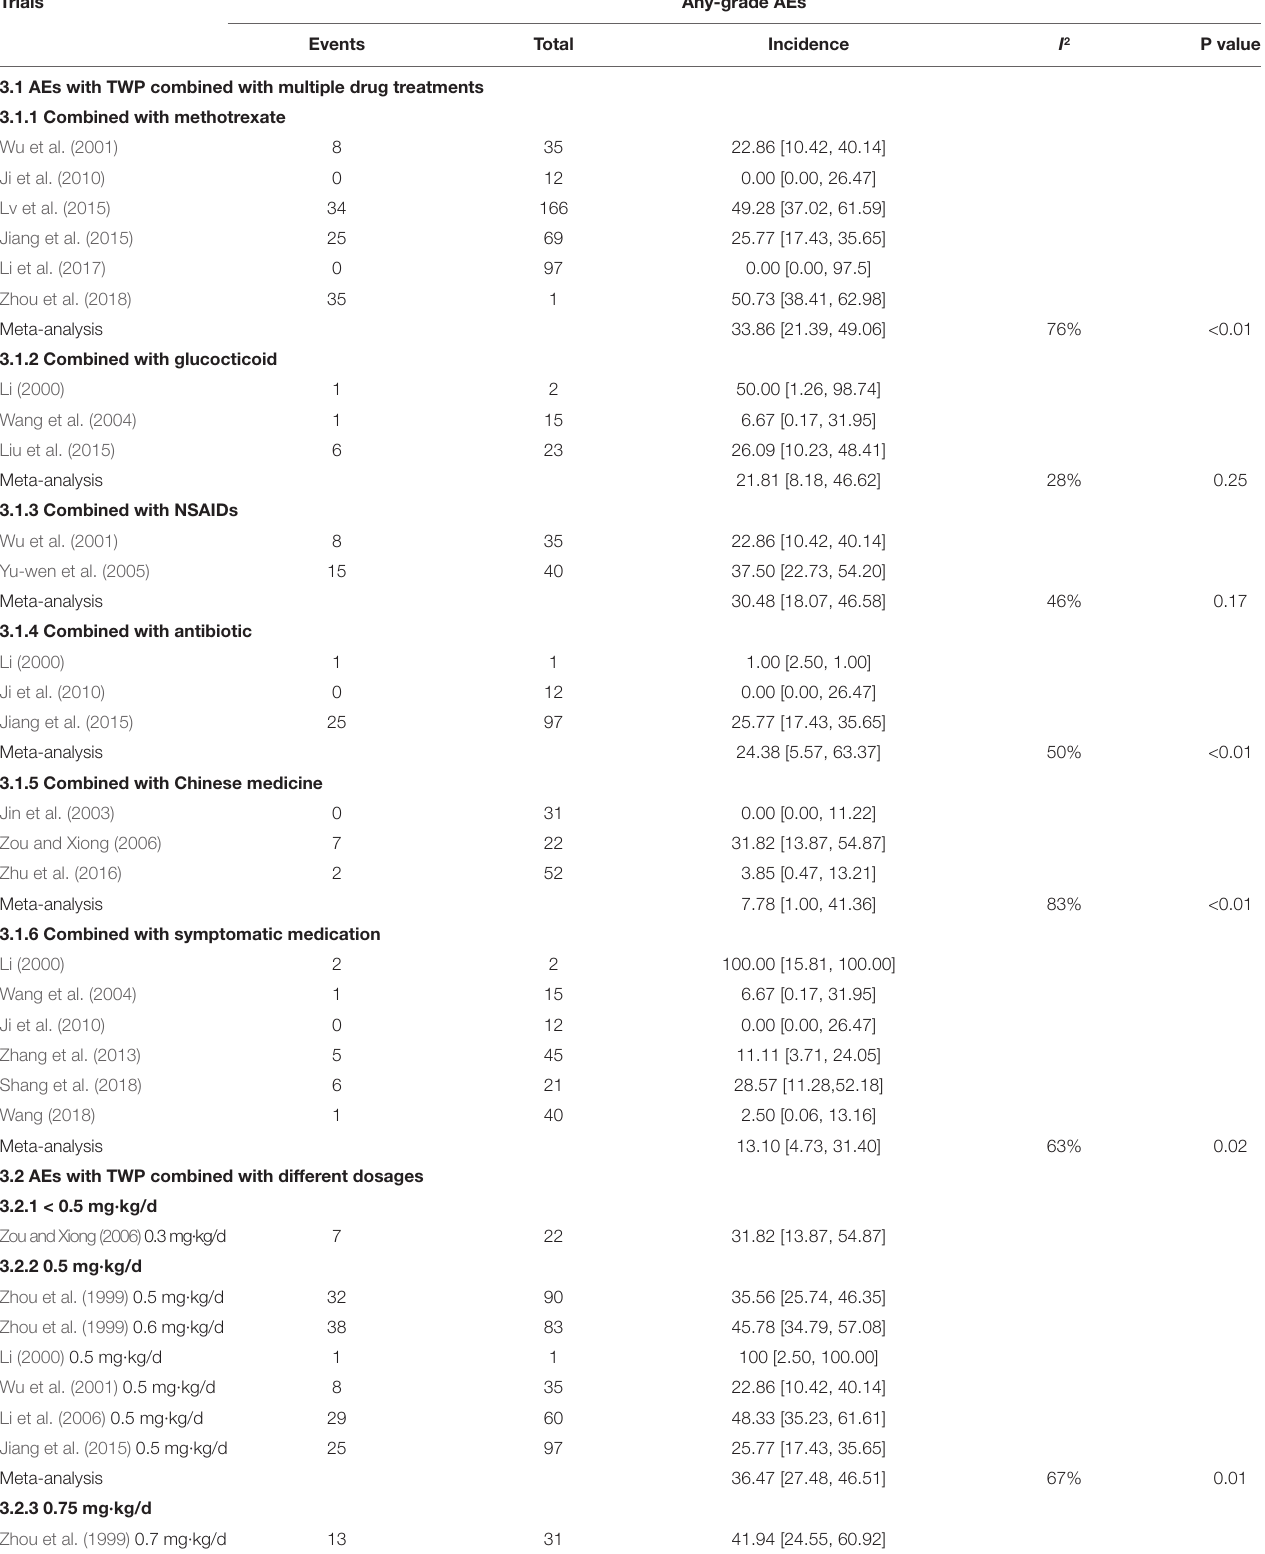
TABLE 3 | Effect of estimates of AEs in the 46 studies included in this meta-analysis. Trials Any-grade AEs Events Total